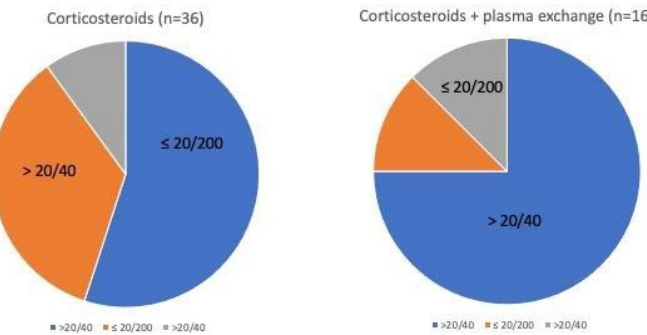
Figure 1. Graphical representation of treatment outcomes of Neuromyelitis optica spectrum optic neuritis with cortico- steroids alone compared to treatment of NMO spectrum optic neuritis with combination of corticosteroids and plasma exchange [32].